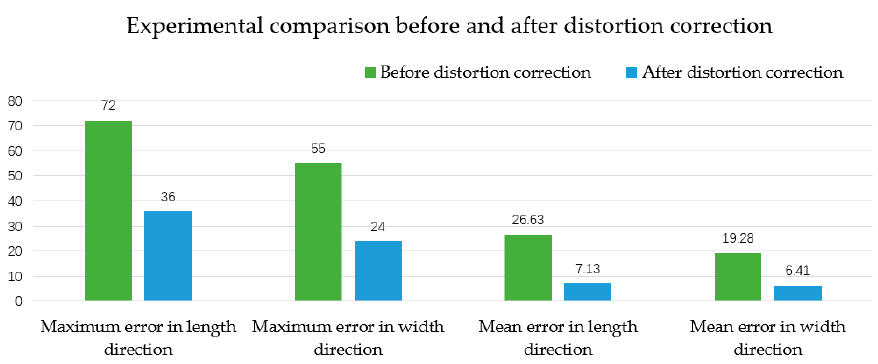
Figure 26. Comparison of before and after distortion correction.